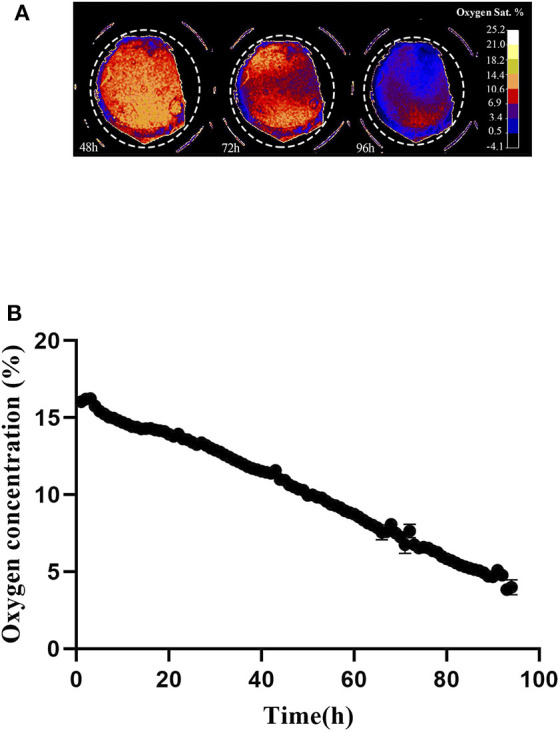
(A) Output from the VisiSens ScientificCal software after calibration and noise reduction. 7 × 104 cells where seeded in a 48 well plate containing the SF-RPsSu4 sensors attached to the bottom of the wells. Images were taken every hour for a period of 96 h. Time points 48, 72, and 96 h are shown. Dashed circle indicate the selection of the ROI. (B) Z-Profile of the oxygen concentration measured at the cell layer by means of the VisiSens TD system and the SF-RPsSu4 sensor foils attached to the bottom of the well. Initial cell density 7 × 104 cells/cm2.